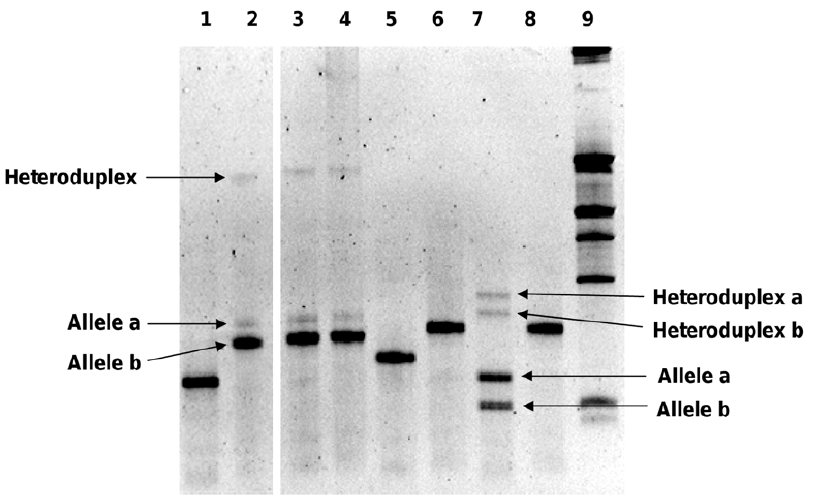
Figure 3. Search for sequence heterogeneity in the V3 region of the 16S rRNA gene by DGGE. Lane 1, MF0 strain; lane 2–4, MFY30 strain; lane 5, MFY32 strain; lane 6, R2f strain; lane 7, KT2440 strain; lane 8, Pf0-1 strain; and lane 9, size ladder (Smart Ladder Small Fragment, Eurogenetec, Belgium).